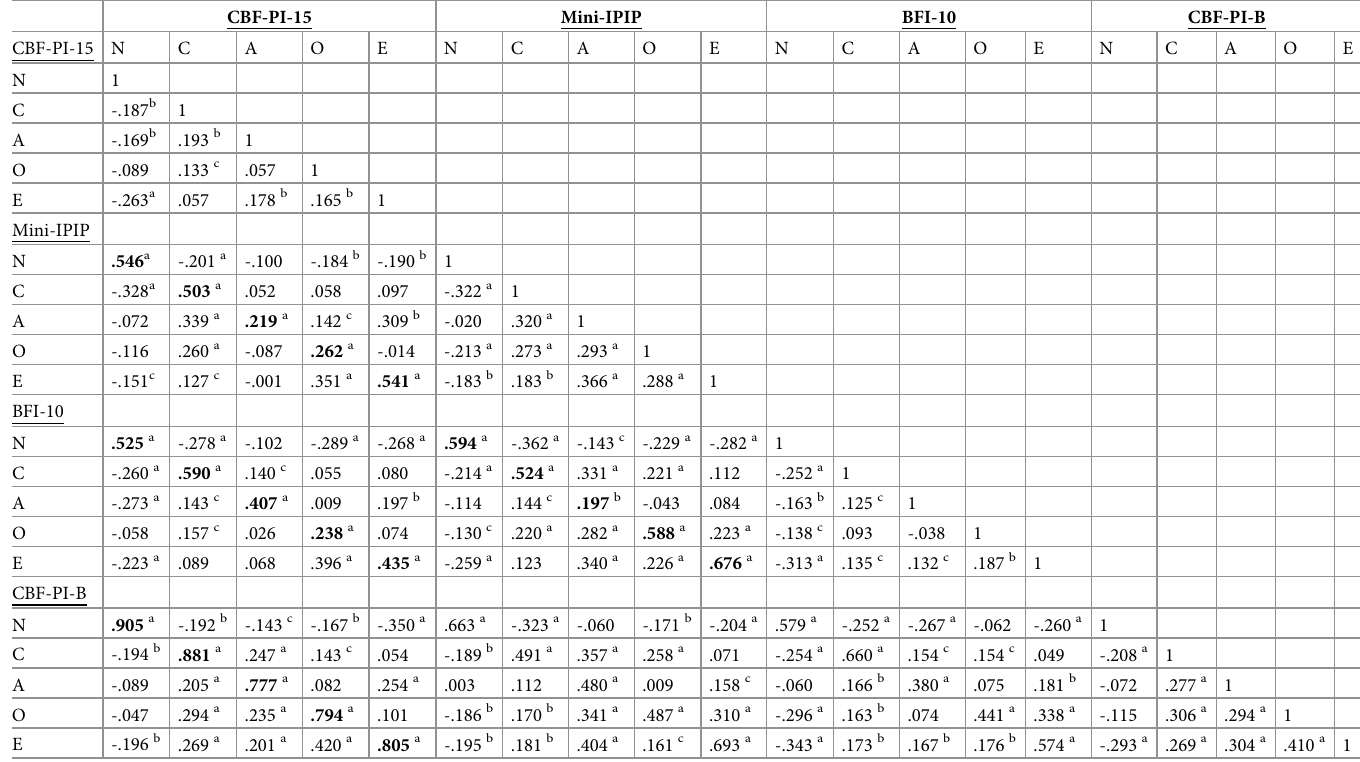
Table 4. Correlations between the CBF-PI-15, Mini IPIP, BFI-10, and